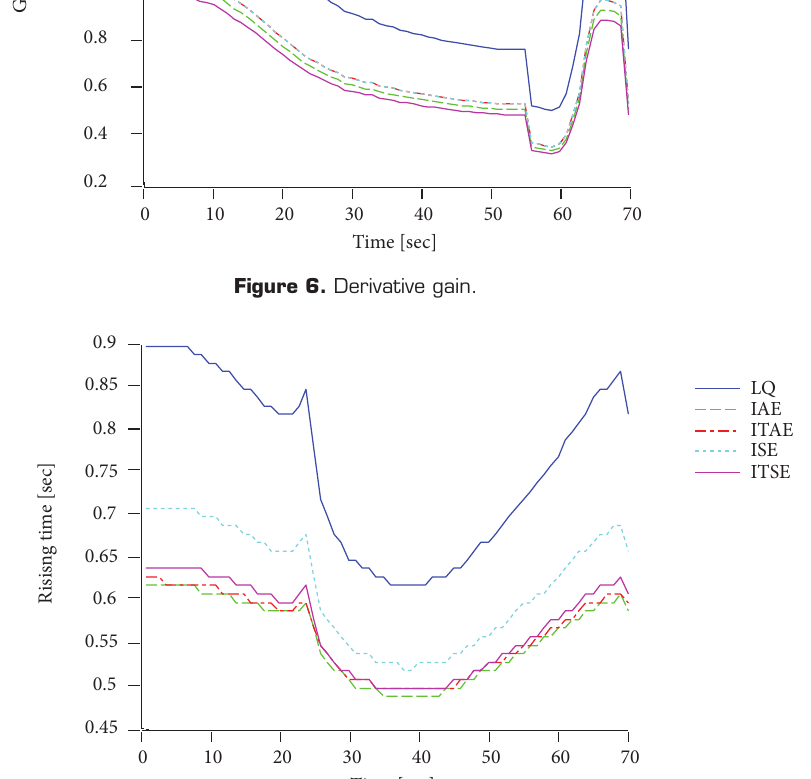
Figure 5. Integral